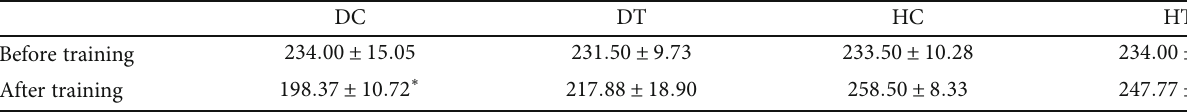
Table 1: Changes of body mass after streptozotocin (STZ) injection (pretraining) and after 6-week exercise treatment (posttraining). Data is shown as the mean ± SEM . DC: diabetic control rats; DT: diabetic and trained; HC: health and control; HT: health and trained. DC DT HC HT Before training 234 : 00 ± 15 : 05